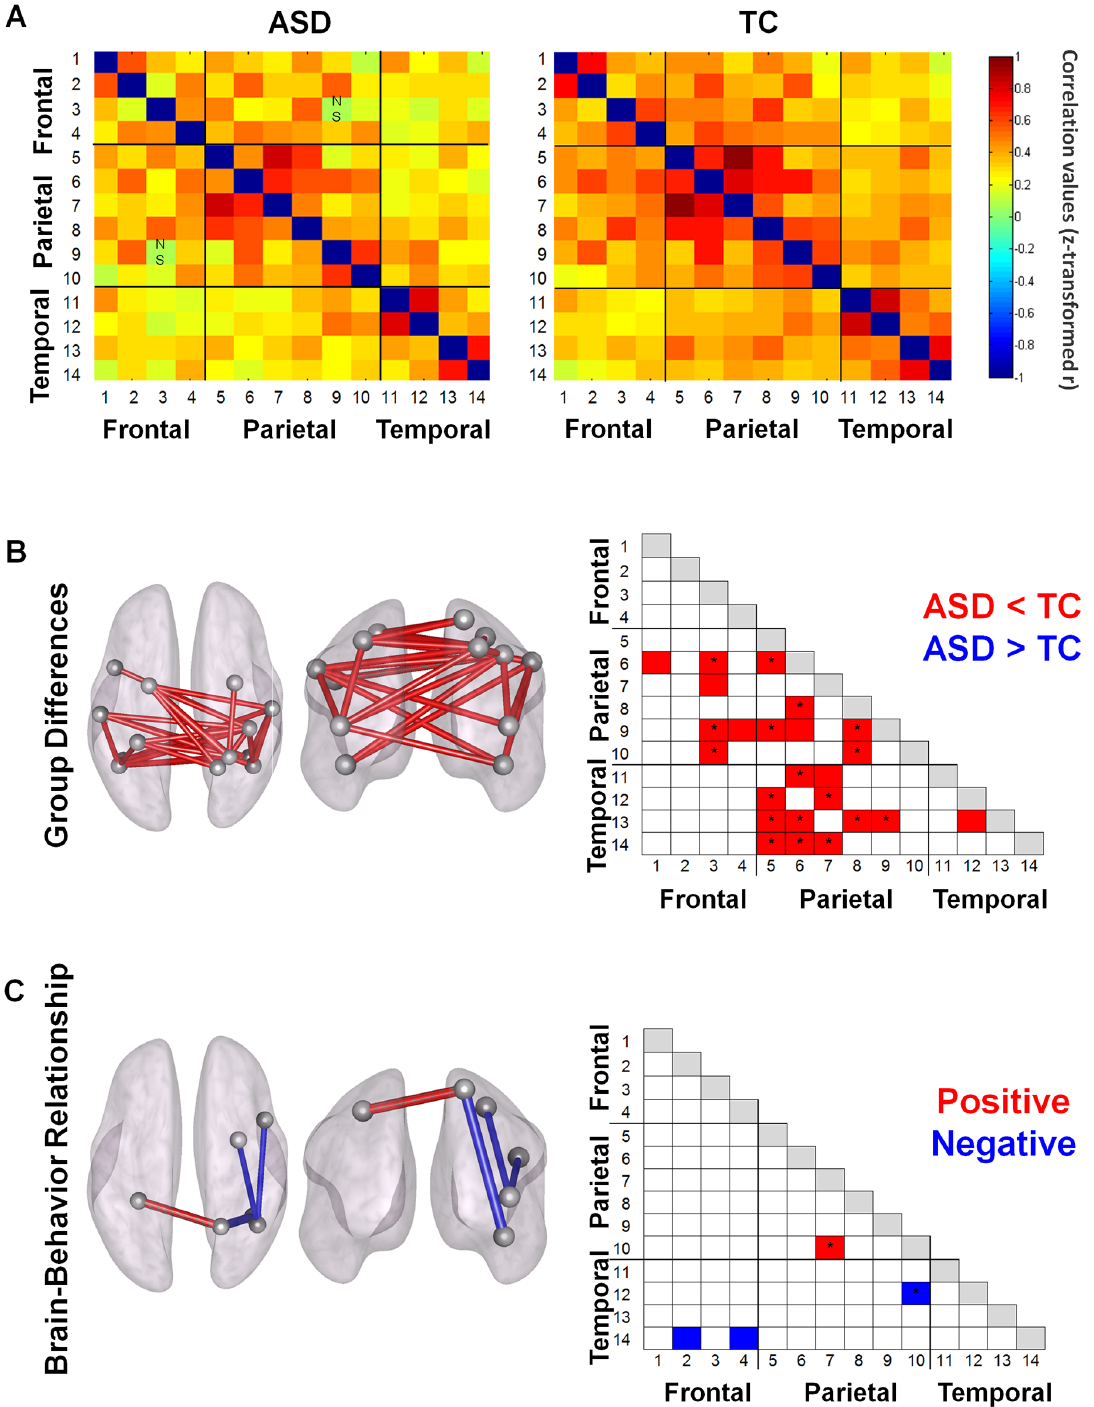
Fig 5. ROI-to-ROI intrinsic functional connectivity (iFC). (A) ROI-to-ROI correlation matrices for the ASD- and TC-groups. Normalized correlation coefficients are shown for each of the 14 x 14 ROI correlations for each group. Each row/column is labeled with a number which corresponds to one of the 14 ROIs reported in Table 2. (B) Between-group comparisons showed significant hypo-connectivity in the ASD-group (ASD < TC). None of the connections showed hyper-connectivity in the ASD-group (ASD > TC). (C) Only a few ROI-to-ROI connections showed a significant relationship with behavioral performance on the emotion recognition task. Particularly for the right superior parietal lobule (SPL, #10), a positive (with right SPL, #7) and negative (with right fusiform gyrus, #12) relationship was shown.